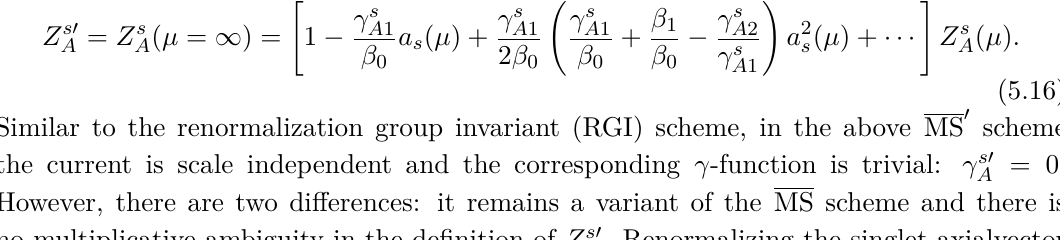
Table 6. Conversion factors Z s N f = 3 , combining different orders of the renormalization group running with different orders of the running of the coupling. The errors reflect the uncertainty in the Λ -parameter of N f = 3 QCD [44].